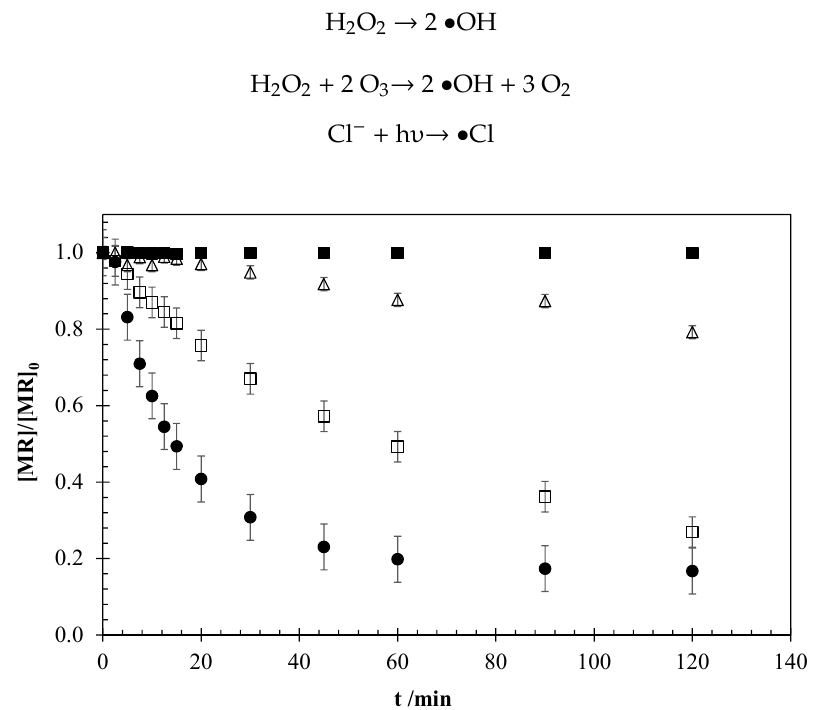
Figure 5. MR concentration profiles for the experiments conducted by photolysis ( ■ ), EO ( □ ), photo-electrochemical oxidation (Photo-EO) ( ● ), and photocatalysis ( Δ ). Operation conditions: [MR] 0 = 5 mg dm − 3 , 15 mA cm − 2 , 0.051 M NaCl, UV-A 8 W.